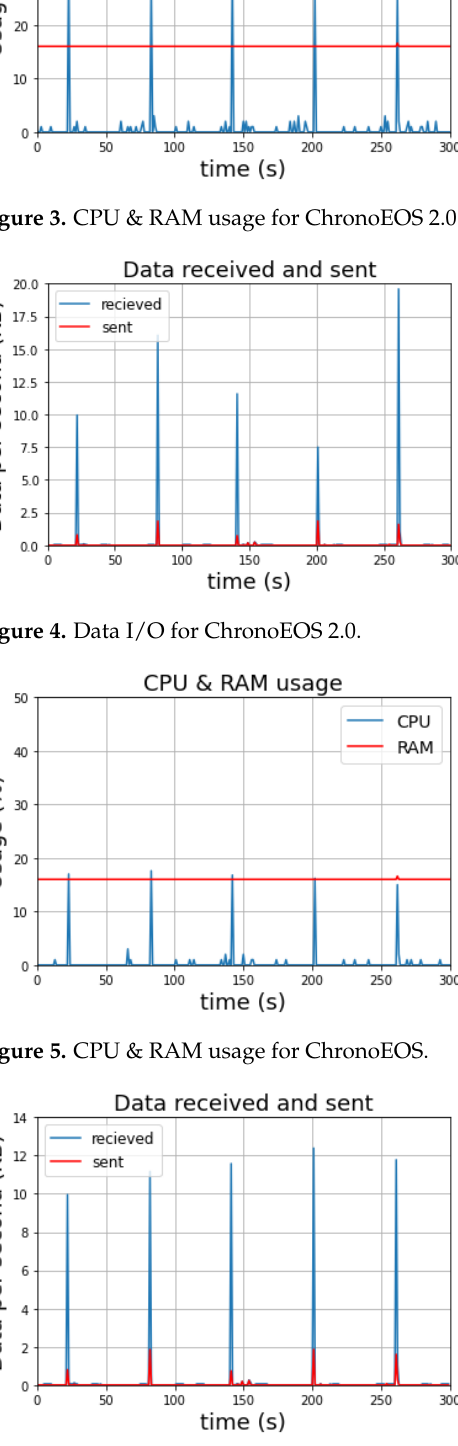
Figure 6. Data I/O for